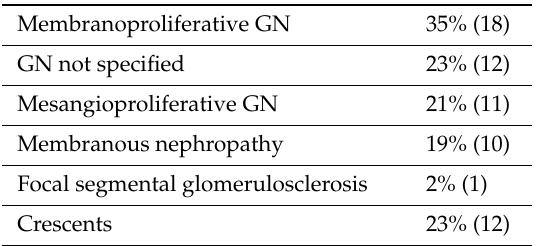
Data in brackets = number of patients;